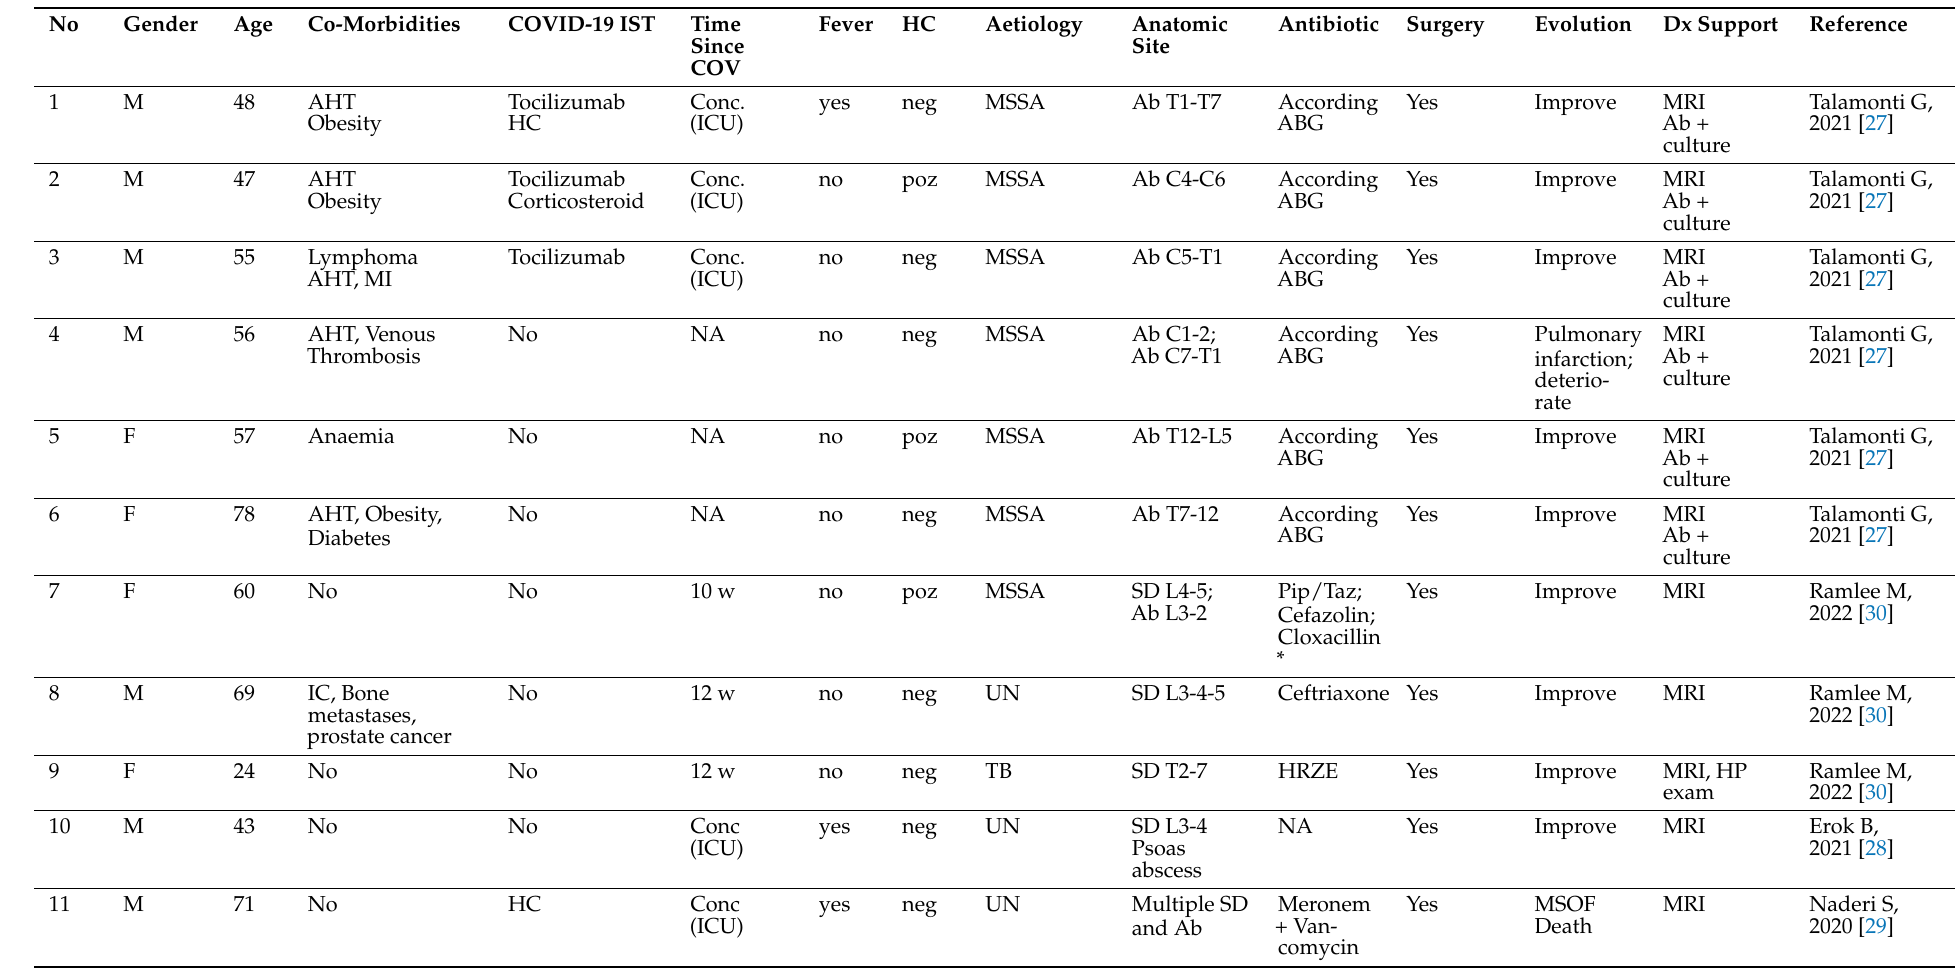
Table 1. Characteristics of reported cases with Spondylodiscitis related to COVID-19